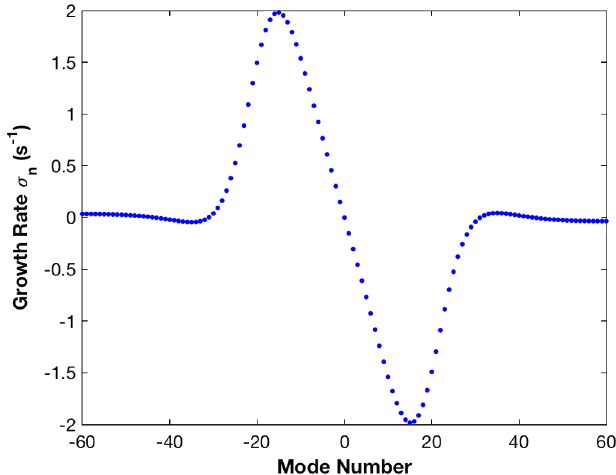
FIG. 13. Growth rates with mode number. Configuration ( α ), OTFB Off.